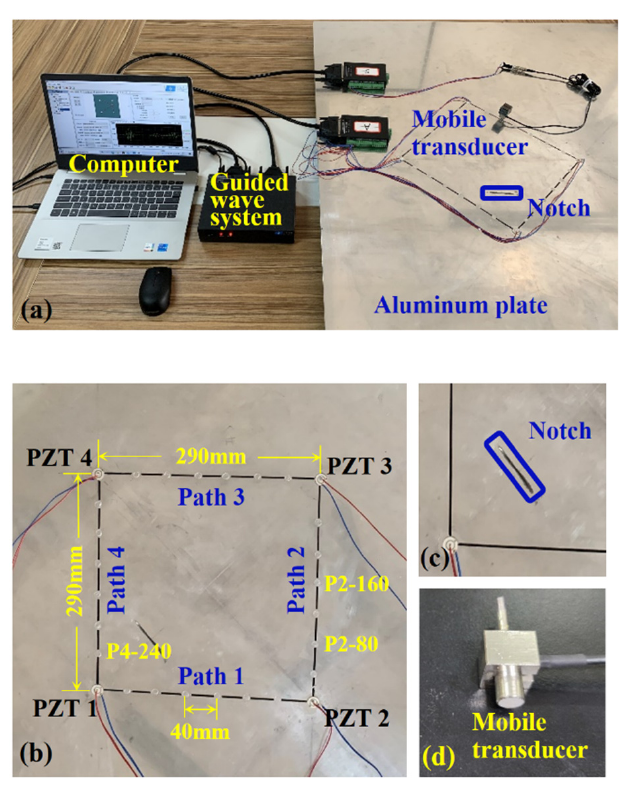
Figure 6. Experimental setup and relevant details: ( a ) experimental setup; ( b ) layout of the detection region; ( c ) the notch; ( d ) the mobile transducer.